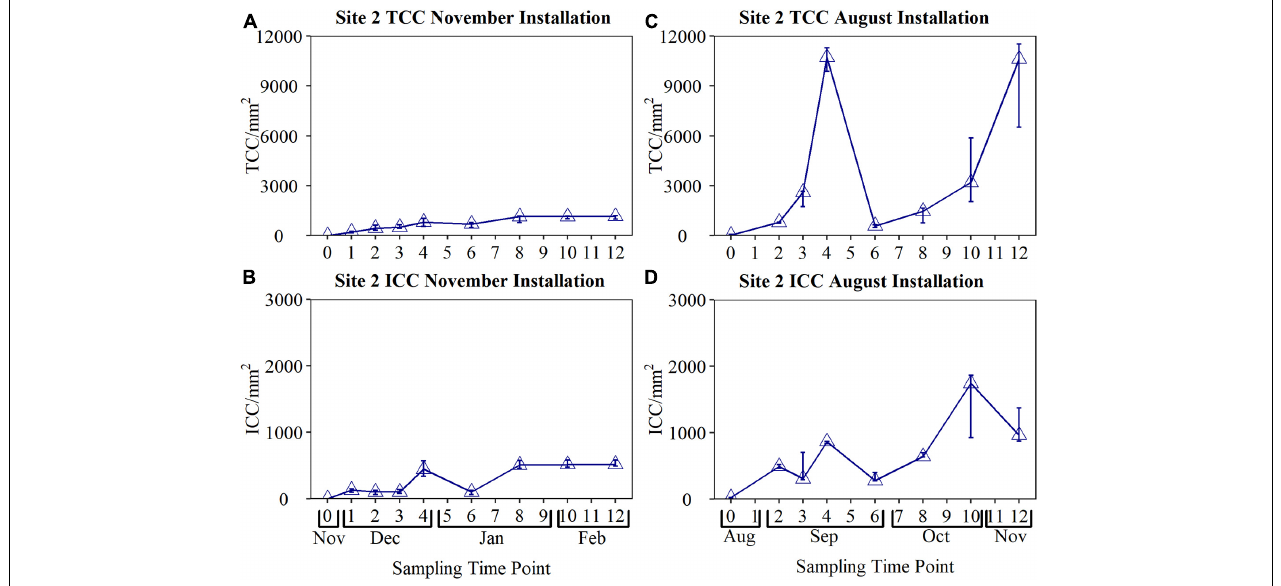
FIGURE 8 | Comparison of biofouling curves obtained from the biofilm monitoring device installed at Site 2 during the November and August installations. Biofilm samples were collected weekly for the first 4 weeks, and every 2 weeks from Weeks 4 to 12 ( n = 3 in all cases, raw data is plotted). TCC, total cell count; ICC, intact cell